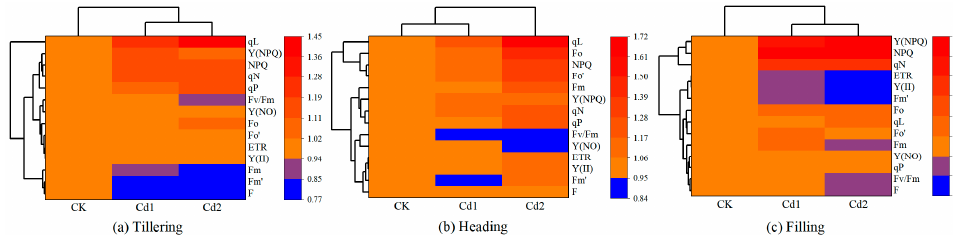
Figure 6. Cluster heat maps of different Cd stress concentrations and Chlorophyll fluorescence parameters during different growth stages (( a ) Tillering; ( b ) Heading; ( c ) Filling). Taking the CK treatment as the control (CK treatment equals 1, denoted by orange) and parameters of another treatment of the stage are expressed by a fraction relative to the corresponding value of the CK treatment. The redder the color is, the bigger it is relative to CK, and the bluer the color is, the smaller it is relative to CK.